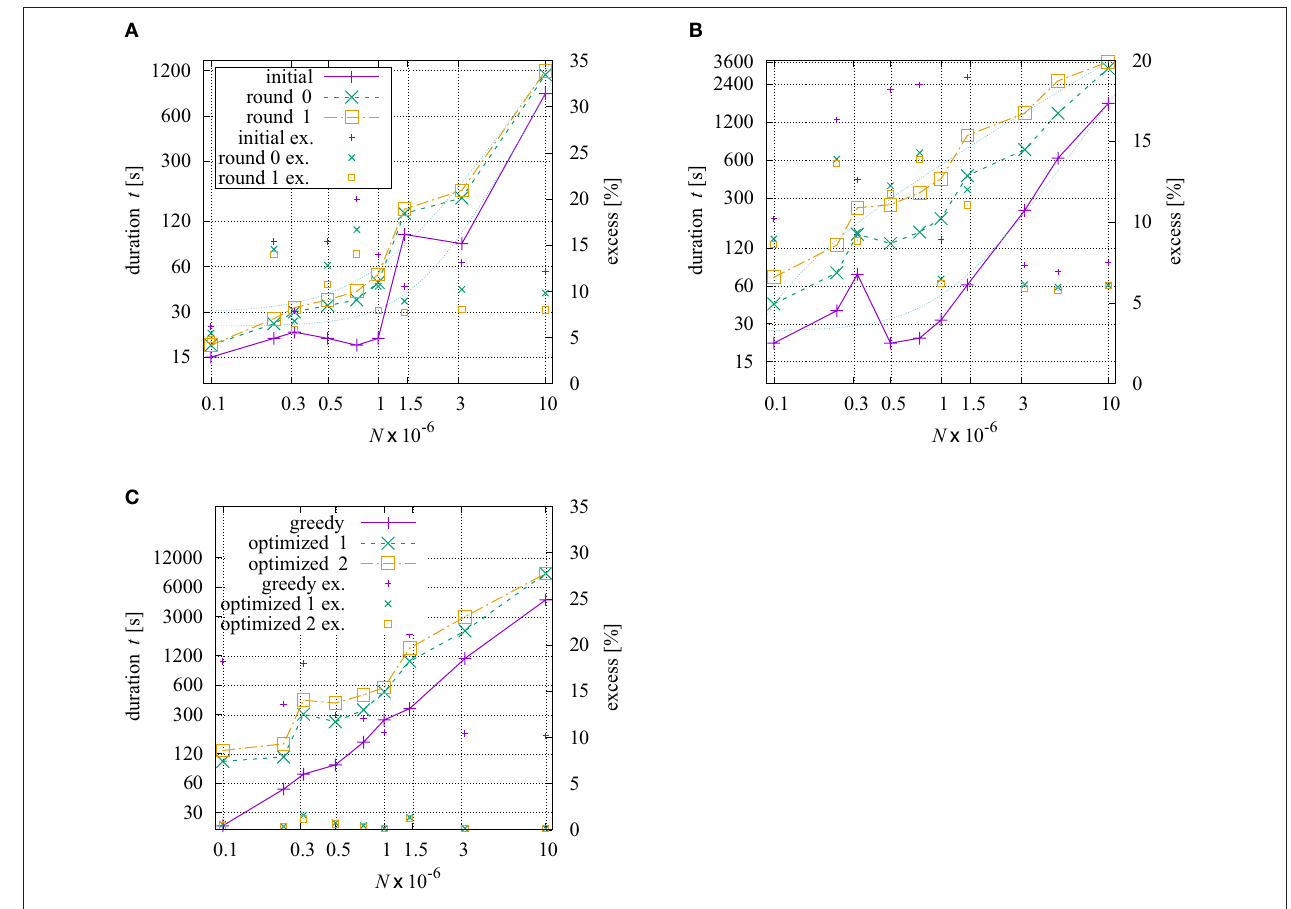
FIGURE 10 | Processing time and excess (over best known solution) dependent on size N of all TSP instances from Table 2 : (A) DoLoWire; (B) POP+ using same legend; (C)